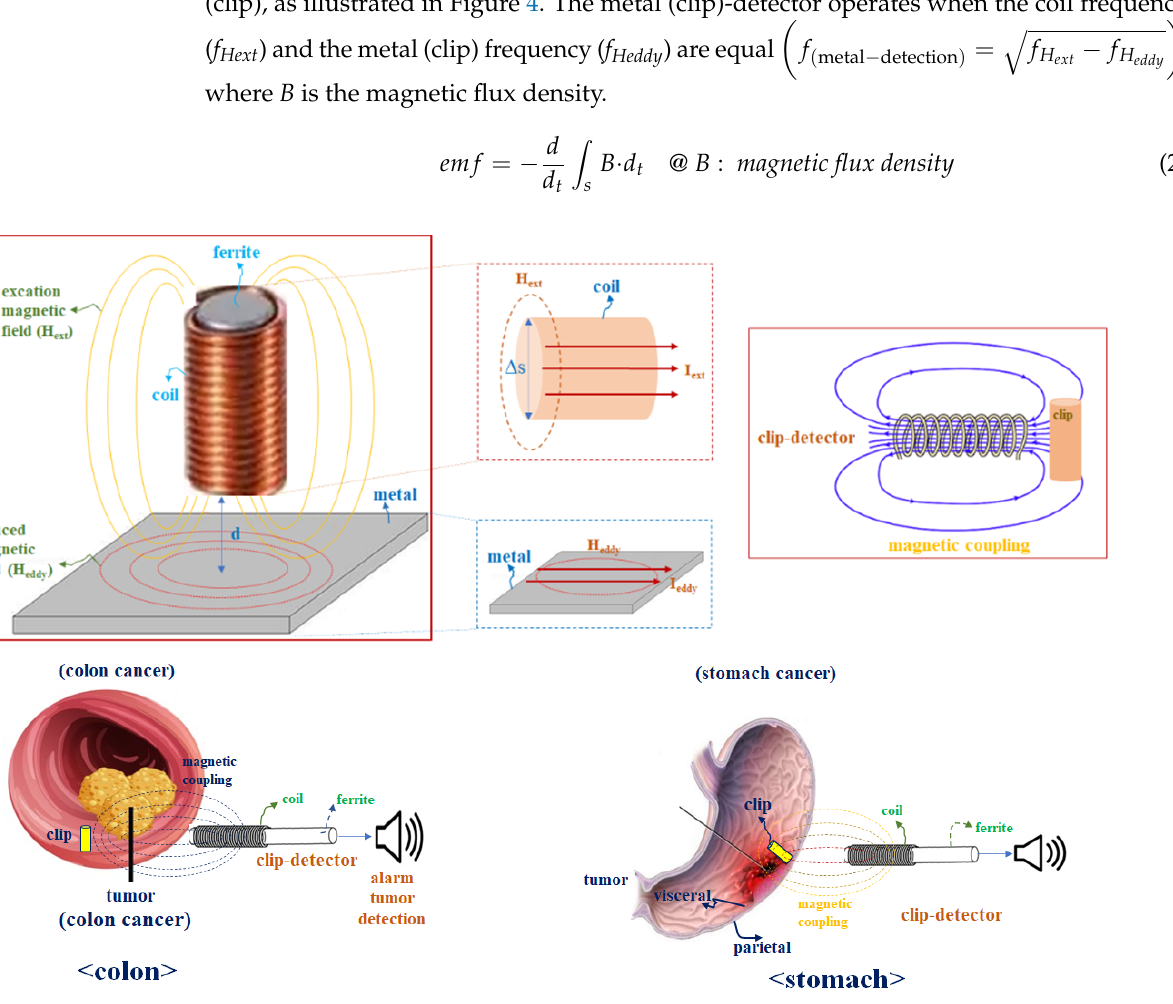
Figure 4. Schematic of magnetic coupling between the clip and detector.